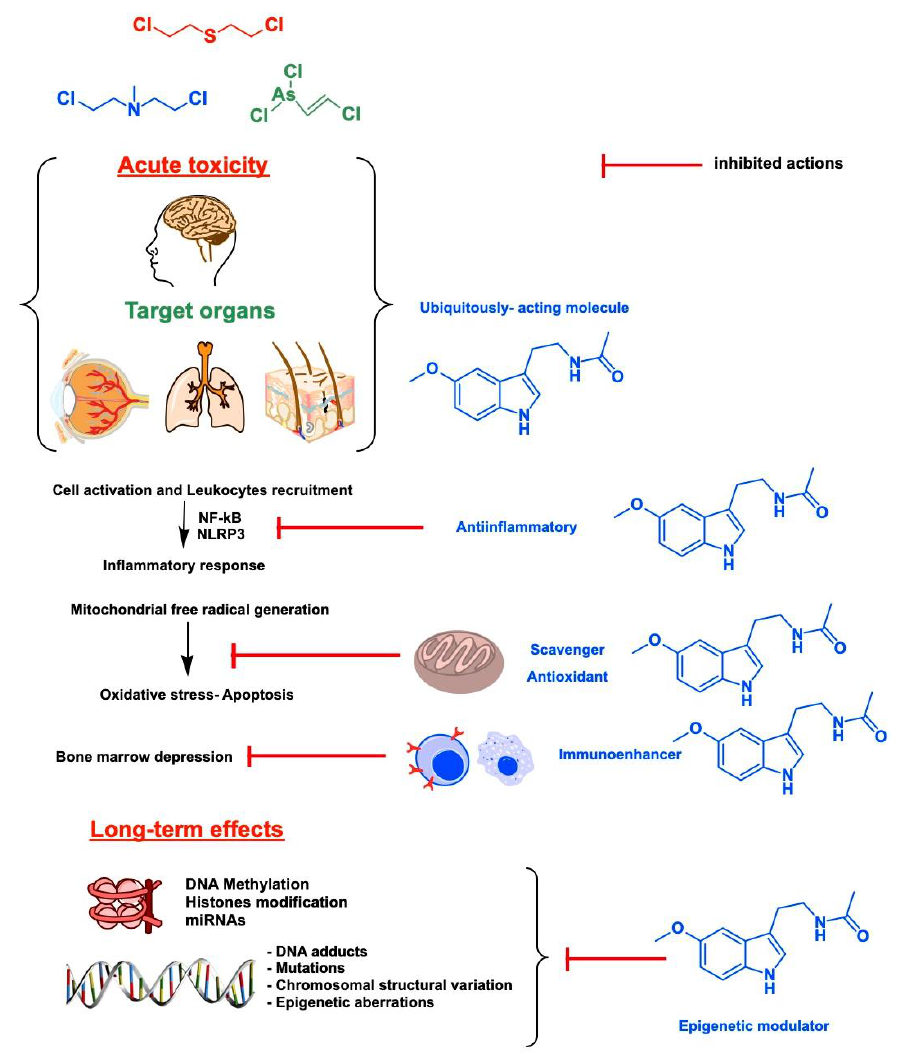
Figure 2. Summary of the cellular and molecular mechanisms displayed by melatonin against vesicant chemical warfare agents (CWAs).